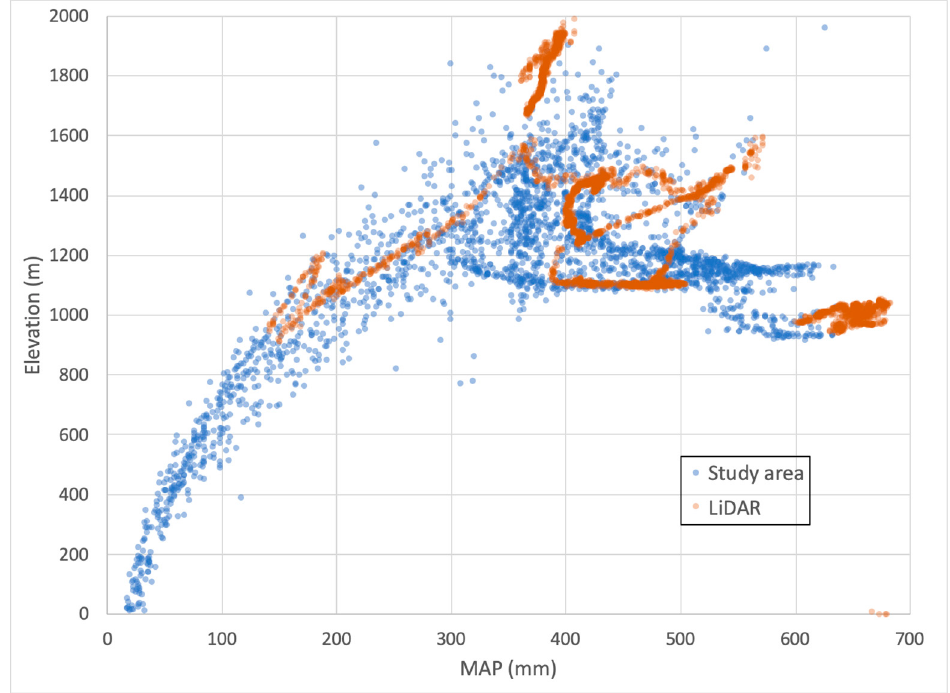
Figure 2. The elevation and MAP of samples of LiDAR training data (randomly sampled 500 m apart) and the study area (randomly sampled 2000 m apart). Please note that the color of data points is 50% transparent providing an indication of data density.